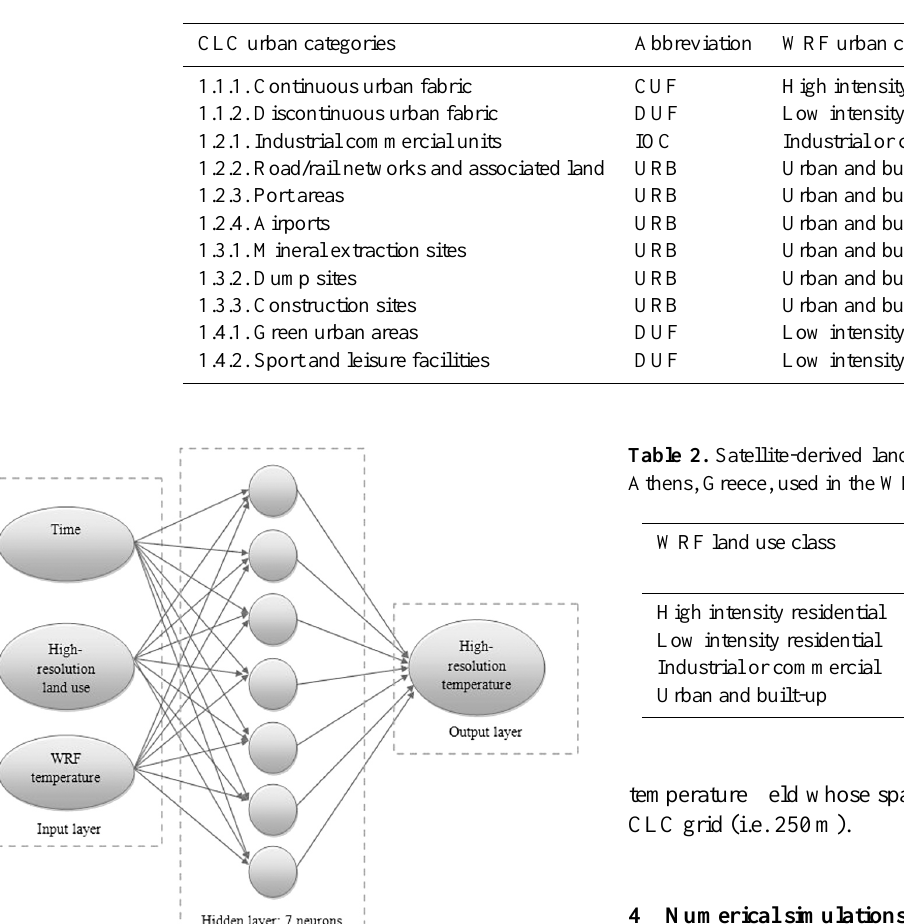
Table 1. Summary of the mapping scheme between the CLC urban land use elements and IGBP (WRF) urban land use categories.